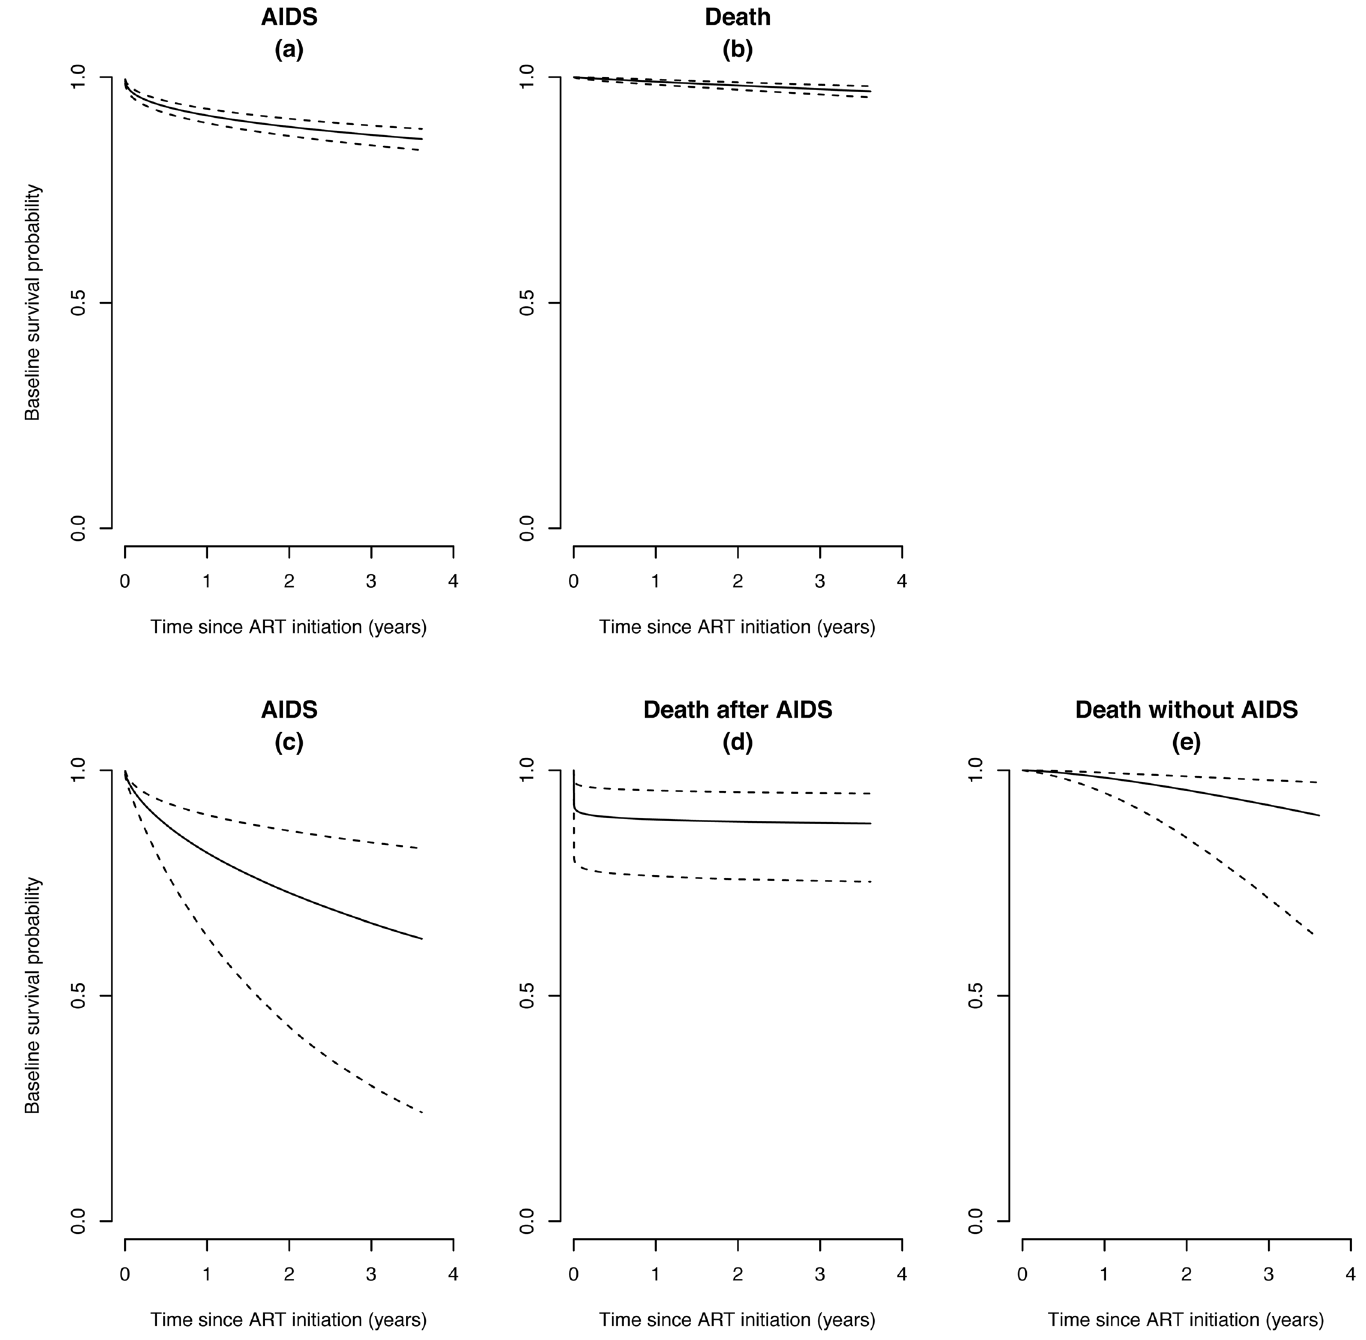
Fig 2. Survival Probabilities on ART in Subjects without AIDS History before ART. (a) Survival without AIDS on ART in Weibull regression analysis. (b) Overall survival on ART in Weibull regression analysis. (c) Survival without AIDS on ART in semi-competing risks analysis. (d) Time to death without acquiring AIDS during ART in semi-competing risks analysis. (e) Time to death following new AIDS events during ART in semi-competing risks analysis. Dotted lines indicate ranges of 95% CIs.